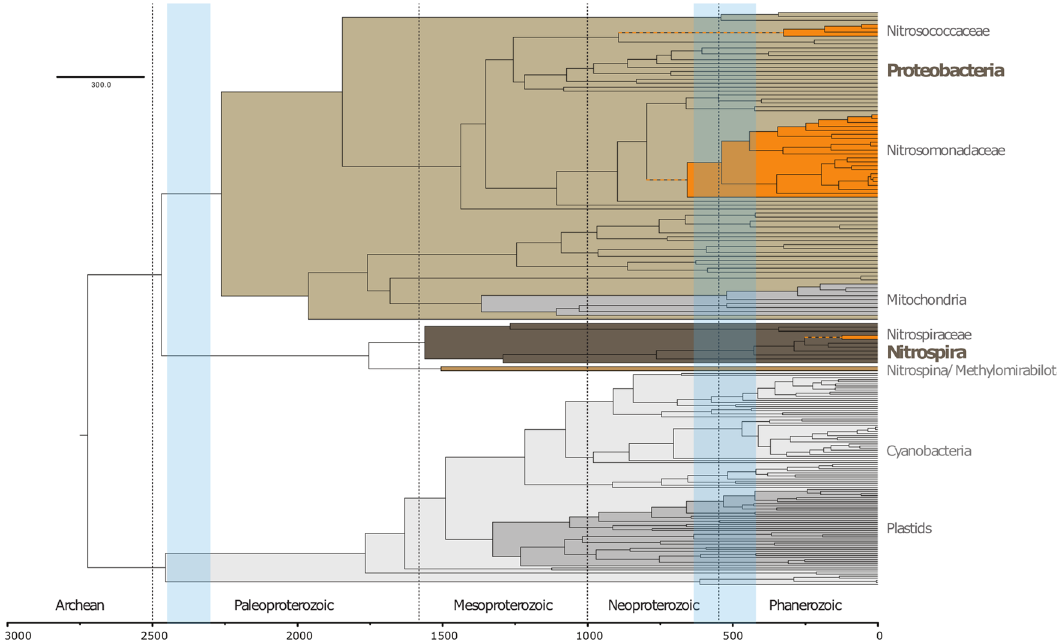
Figure 3. Molecular clock showing estimated age of clades of ammonia oxidizing bacteria. Phylum-level clades highlighted in gray and brown, with ammonia oxidizing clades highlighted in orange. Approximate timing of Great Oxygenation Event (~ 2.45–2.3 Ga) and Neoproterozoic/Paleozoic Oxygenation Event (~ 635–420 Ma) shown with light blue bars. While stem lineages of AOB clades may predate the NOE, the radiation of crown groups all occur broadly coincident or subsequent to the NOE, suggesting that evolutionary radiations of nitrogen-cycling organisms may have been causally linked with expansions in ocean oxygenation and/or productivity during this time period.